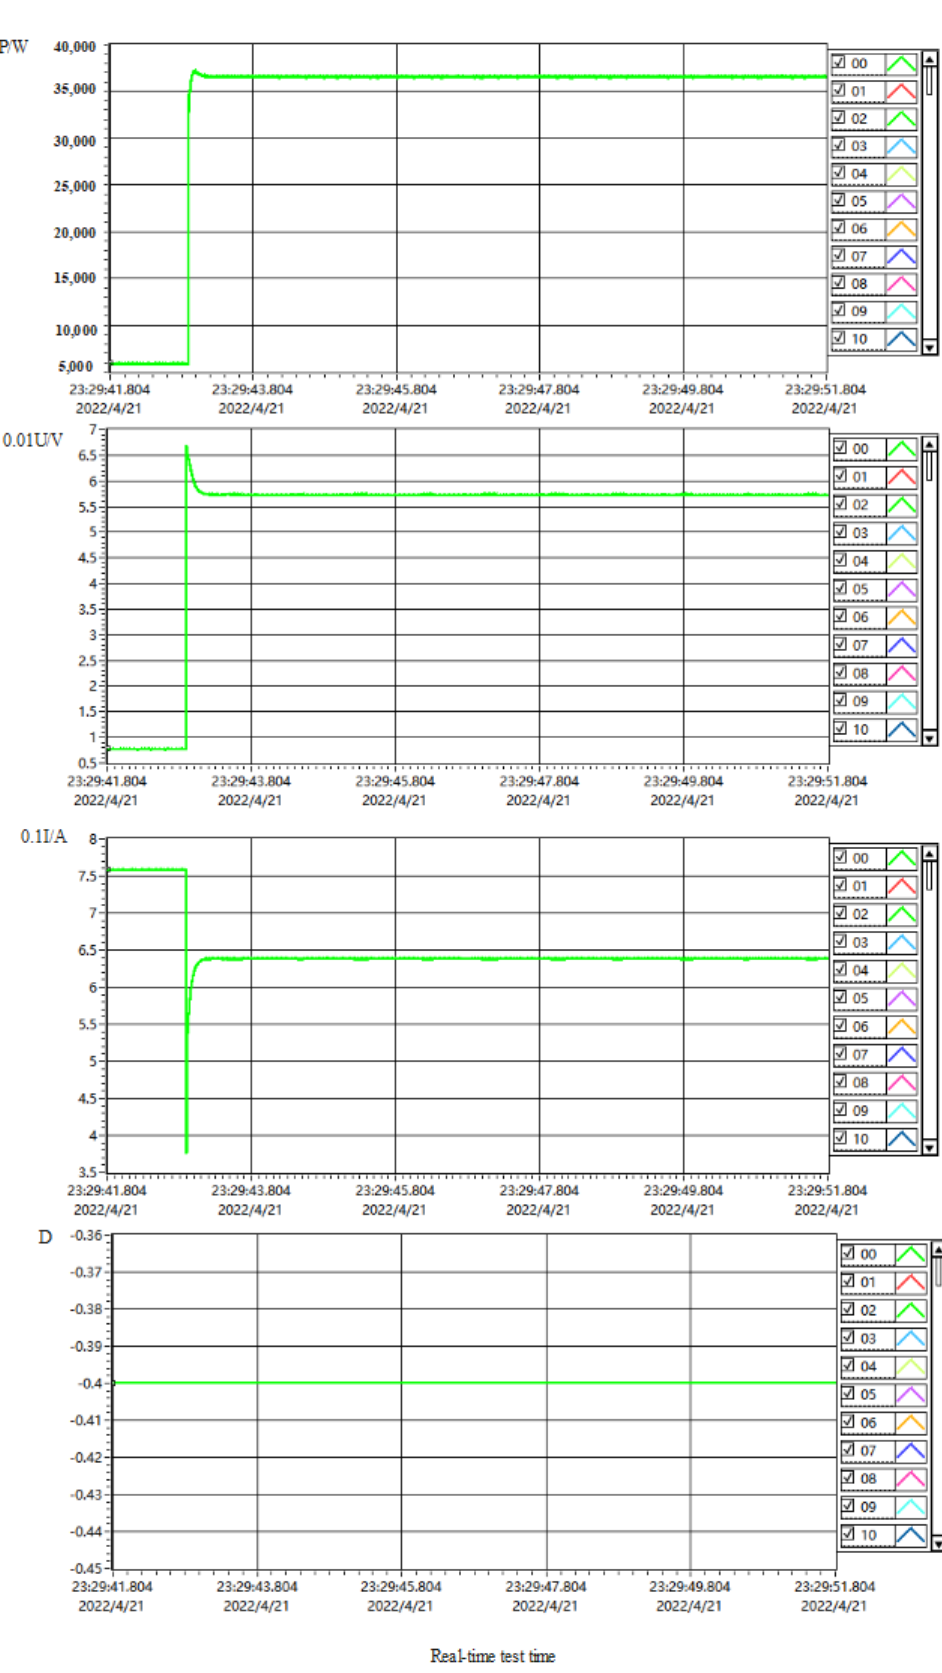
Figure 19. ISMA output curves based on real-time simulation platform.